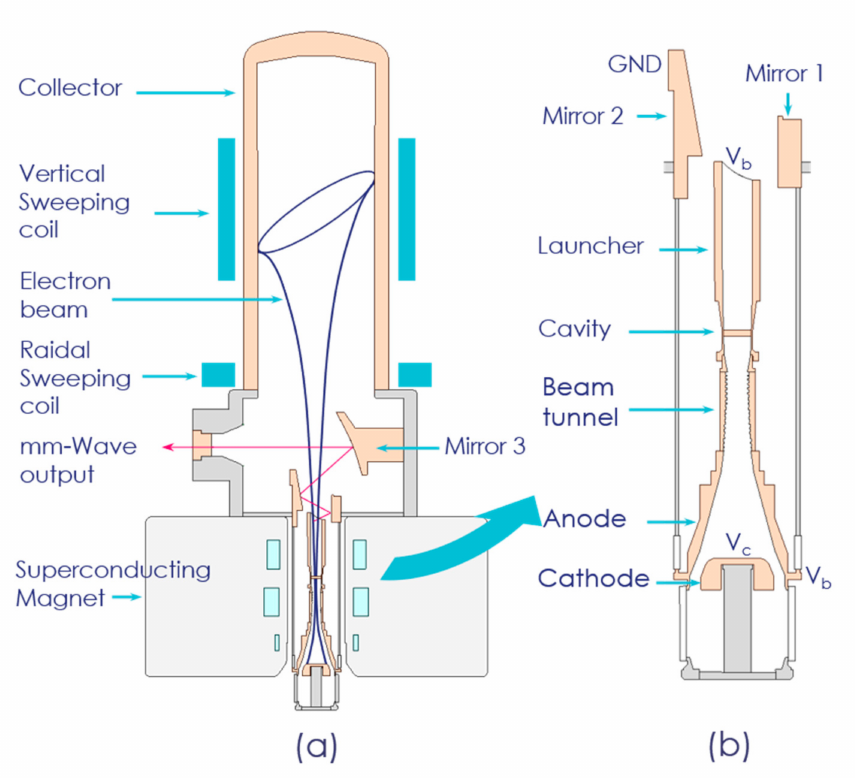
Figure 2. Schematic view of a gyrotron. ( a ) Cross-sectional view of the whole tube. ( b ) Cross-sectional view of the cathode–resonator–mirrors